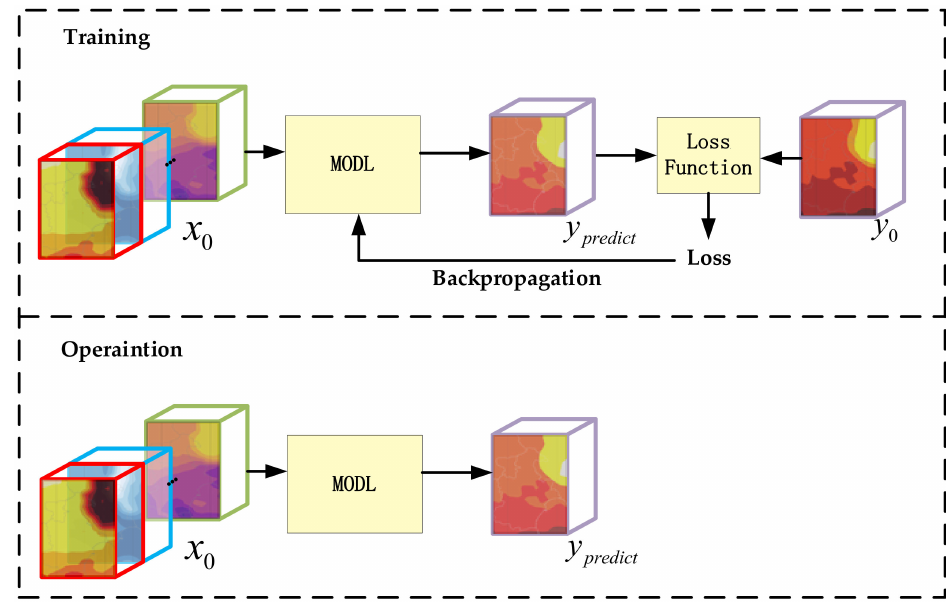
Figure 3. The training and operational process of model output deep learning